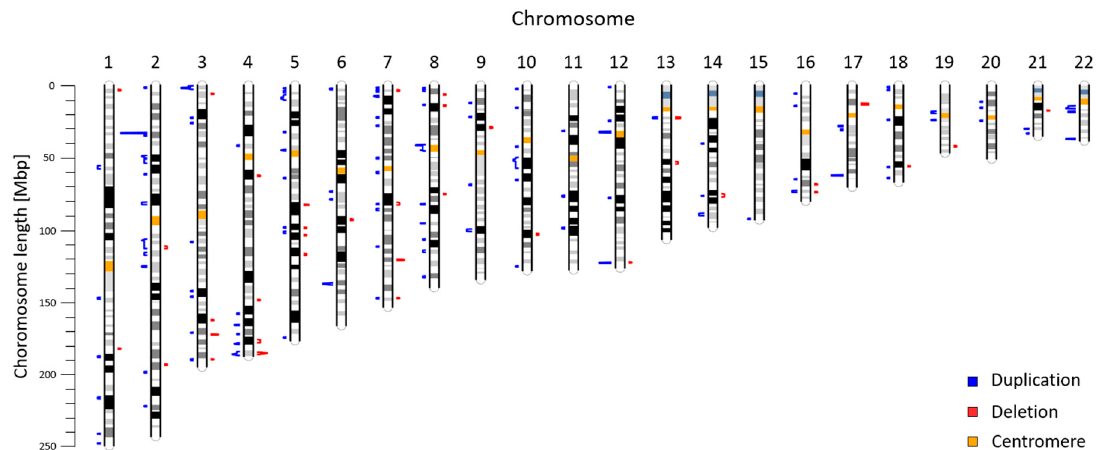
Figure 1. Chromosomal location of maternal CNVs identified by NIPT. The length of blue (duplication) and red (deletion) bars corresponds to the frequency of CNV ranging from minimum of 1 to maximum of 11 detections.